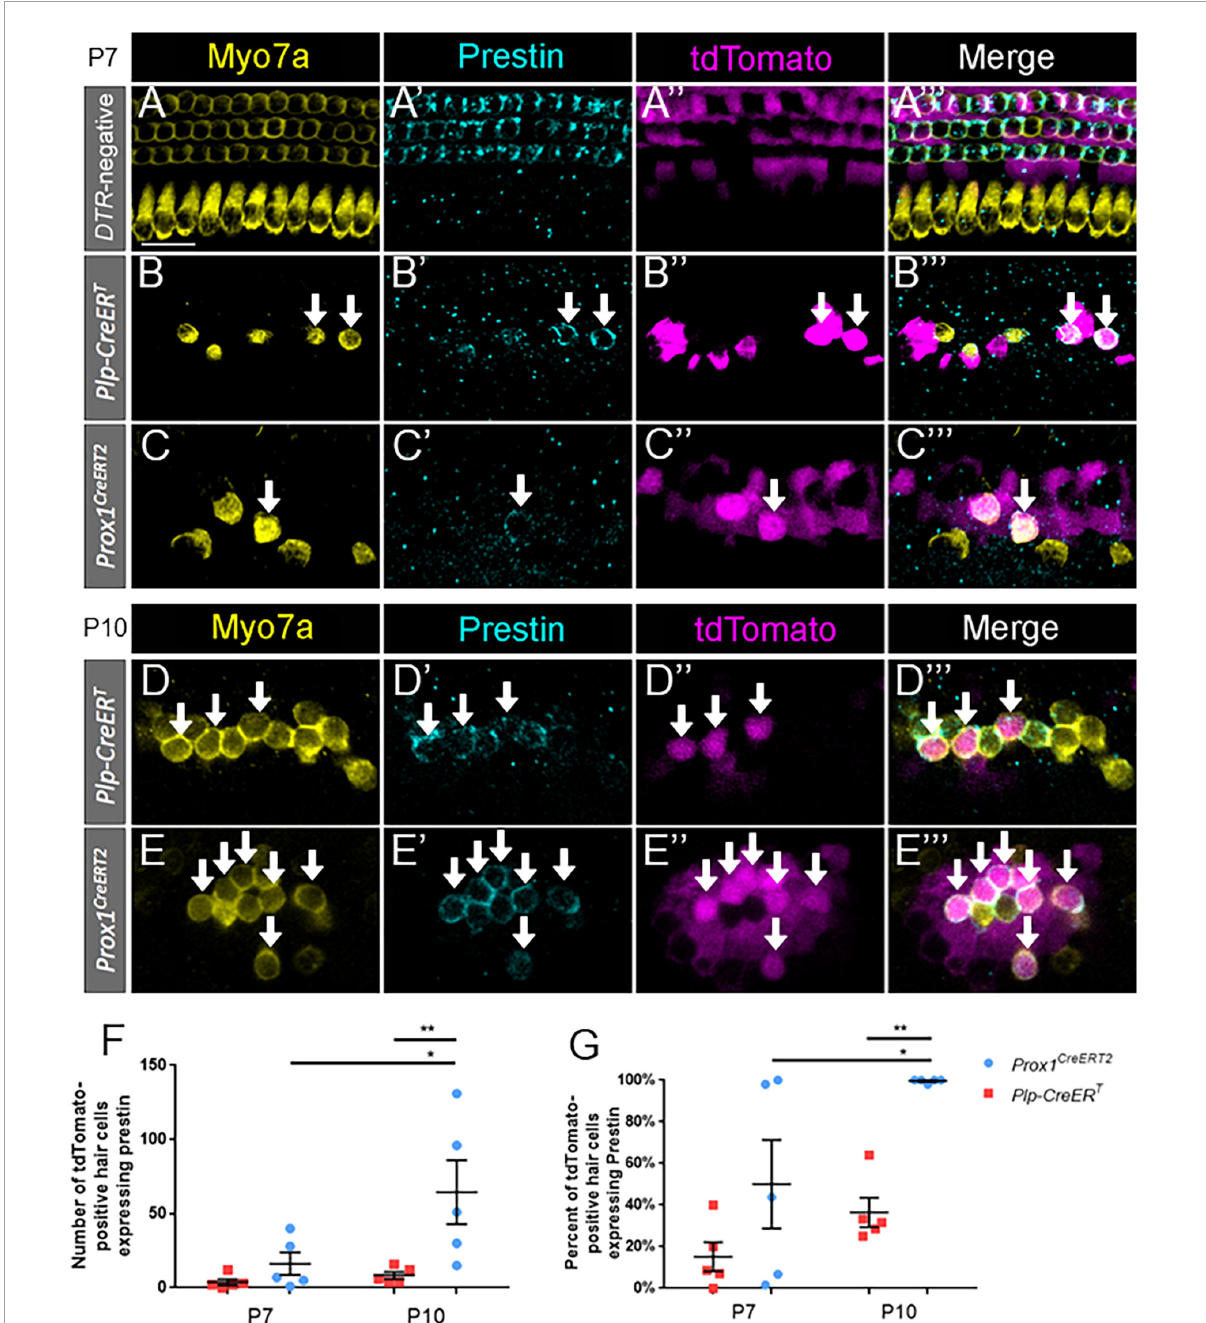
FIGURE4 Prestin expression in regenerated hair cells increases with age and is proportionally higher in pillar and Deiters’ cells. (A–E”’) Representative confocal slice images from the middle turn of Pou4f3 DTR -negative (A–A”’) and from the apical turn of Plp-CreER T :Rosa26 tdTomato :Pou4f3 DTR (B–B”’,D–D”’) and Prox1 CreERT 2 :Rosa26 tdTomato :Pou4f3 DTR (C–C”’,E–E”’) mice at P7–P8 (A–C”’) and P10 (D–E”’) that were injected with tamoxifen at P0 to induce tdTomato expression in the two supporting cell subpopulations and with DT at P1 to induce hair cell damage. Samples were immunostained with anti-Myo7a antibodies (yellow) to label hair cells and anti-prestin antibodies (blue) to label mature outer hair cells. tdTomato was detected using endogenous fluorescence (magenta). Arrows indicate Myo7a-positive/prestin-positive/ tdTomato-positive cells that are regenerated, fate-mapped mature outer hair cells. Scale bars: 25 µ m. (F) A significantly greater number of prestin-positive regenerated hair cells were seen in the supporting cells located in the lateral compartment and fate-mapped by Prox1 CreERT 2 between P7 and P10 and between the supporting cell populations targeted by the two CreER lines at P10. (G) Data from panel (F) normalized to the total number of Tomato-positive/Myo7a-positive cells in each mouse model. * p < 0.05; ** p < 0.01, determined using two-way ANOVA with a Sidak’s post-hoc test. Data are presented as mean ± SEM; n = 5. N.S., not